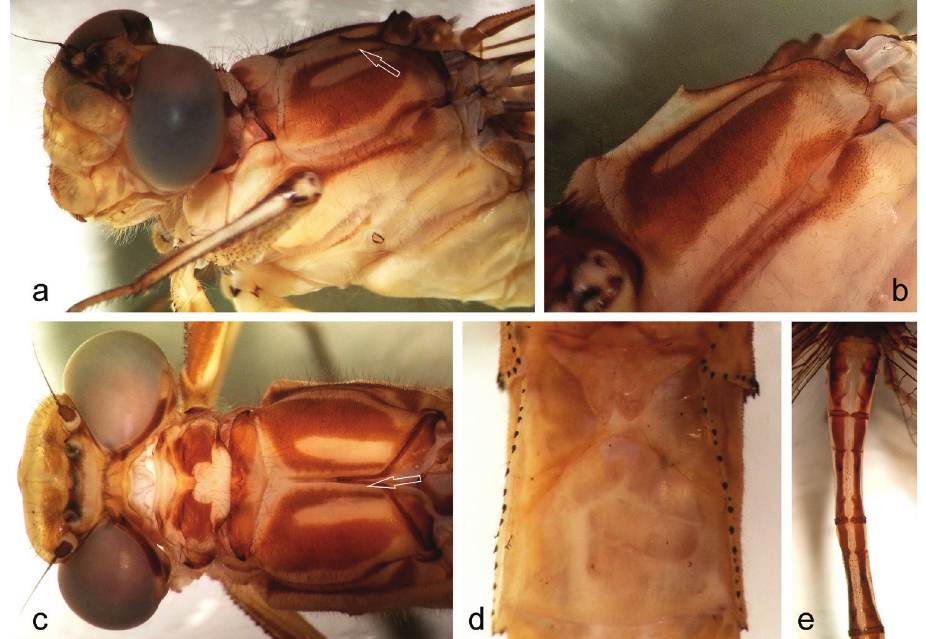
Figure 8. Notogomphus cf. zernyi , a teneral female from the Mikwa Stream, near Chingombe, Zambia, with details of the thoracic pattern in dorsal and lateral views ( a–c ), a subgenital plate ( d ) and the pattern of the proximal segments of abdomen in dorsal view ( e ); arrows indicate the pale distal part of the mid- dorsal stripe (phot. B.